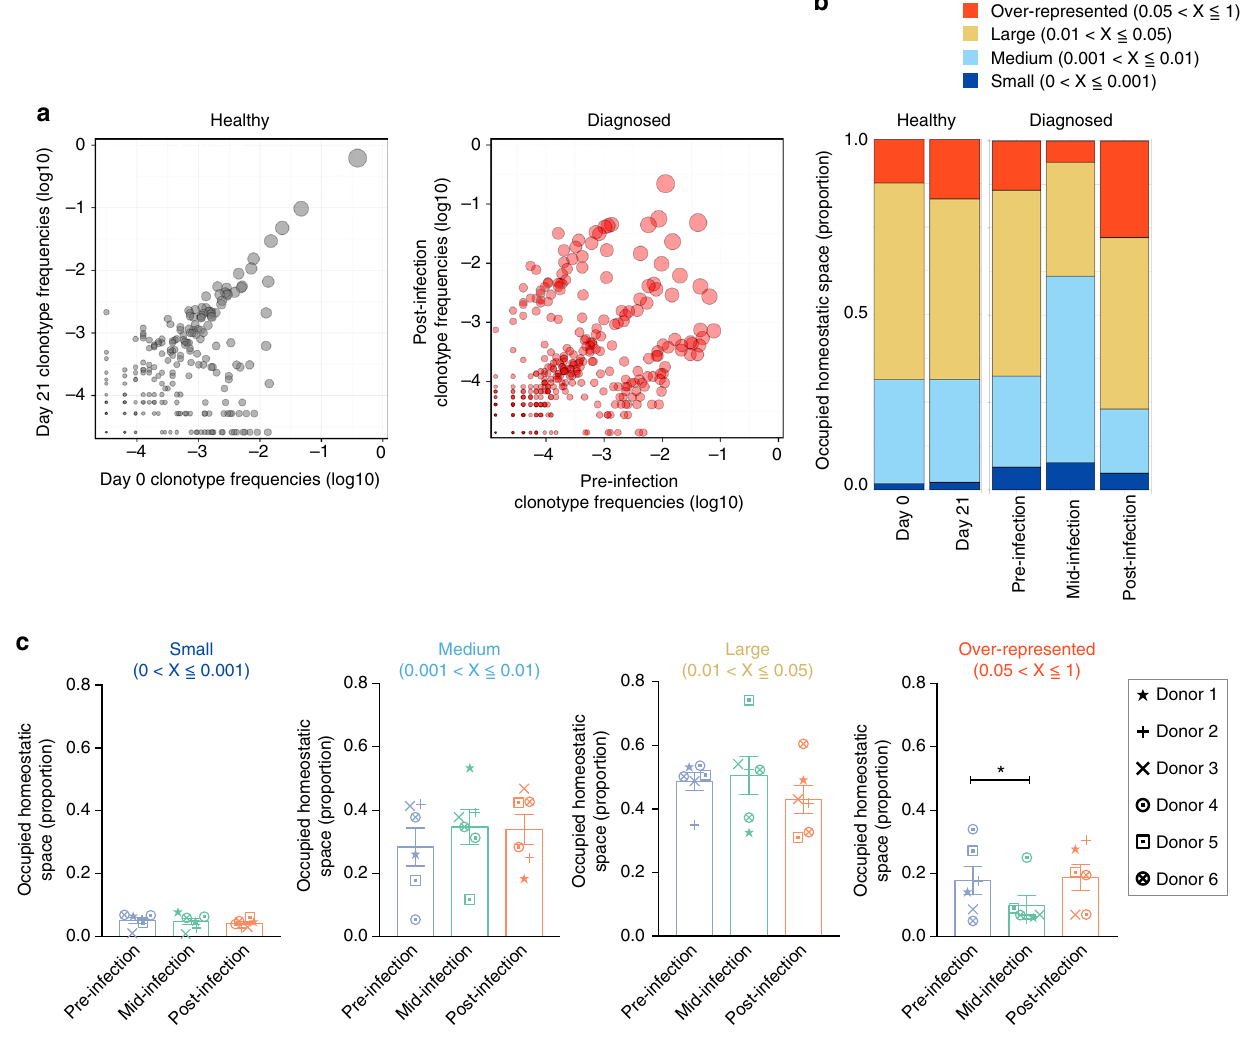
Fig. 3 The over-represented MAIT cell clonotypes undergo transient contraction during enteric fever. MAIT cells were sorted from frozen PBMCs from six individuals challenged with S . Paratyphi A and diagnosed with enteric fever (pre-, mid-, and post-infection) and the TCR β repertoire analyzed. MAIT cells from healthy individuals sampled twice (21 days apart) were analyzed as a control. a Examples of clonotype abundance scatterplots for a healthy and a diagnosed (donor 1) individual. Scatterplot axes represent log10 clonotype frequencies in each sample (overlapping clonotypes only) and point size is scaled to the geometric mean of the clonotype frequency in both sample time points. b Example graphs of the occupied homeostatic space of MAIT cell clonotypes in a healthy and diagnosed (donor 1) individual. Measured as a proportion taken up by over-represented (0.05 – 1), large (0.01 – 0.05), medium (0.001 – 0.01), and small (0 – 0.001) clonotypes. c Summary graphs of occupied homeostatic space taken up by MAIT clonotypes in diagnosed donor 1 – 6. Line is the mean with error bars representing SEM. Each symbol represents one individual and a key is provided for identi fi cation. Statistical signi fi cance was calculated using Student ’ s paired two-tailed t -test, where * P <